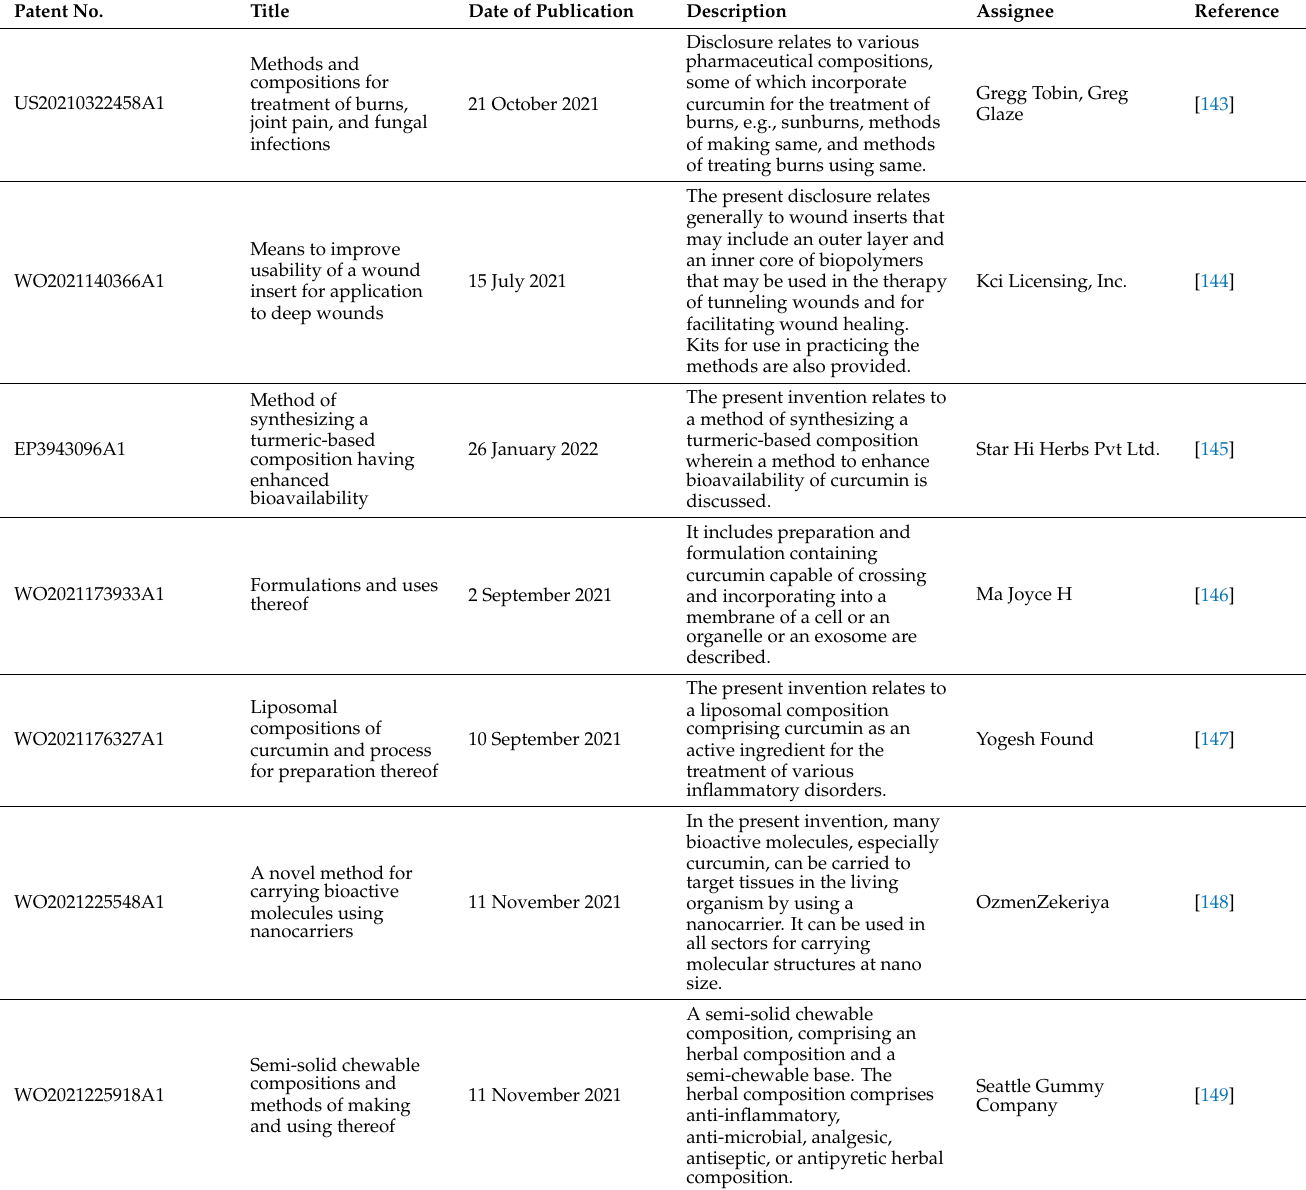
Table 2. Description of numerous patents on curcumin-based formulations for wound